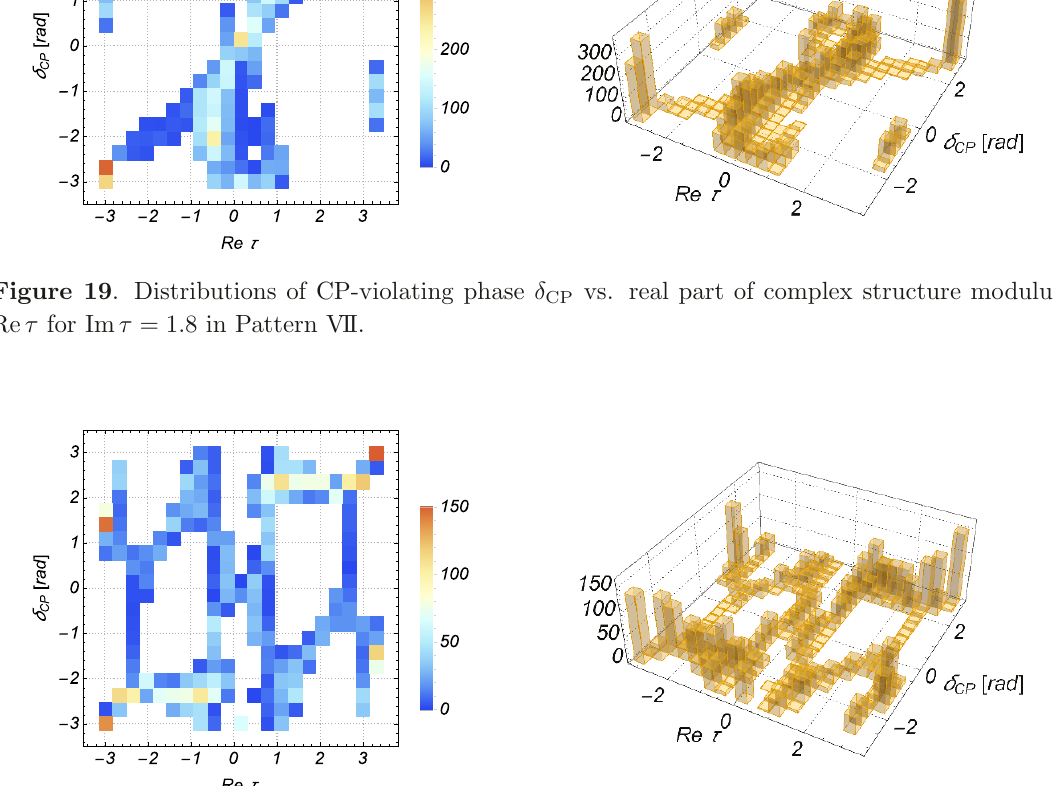
Figure 20 . Distributions of CP-violating phase δ CP vs. real part of complex structure modulus Re τ for Im τ = 2 . 0 in Pattern VII.